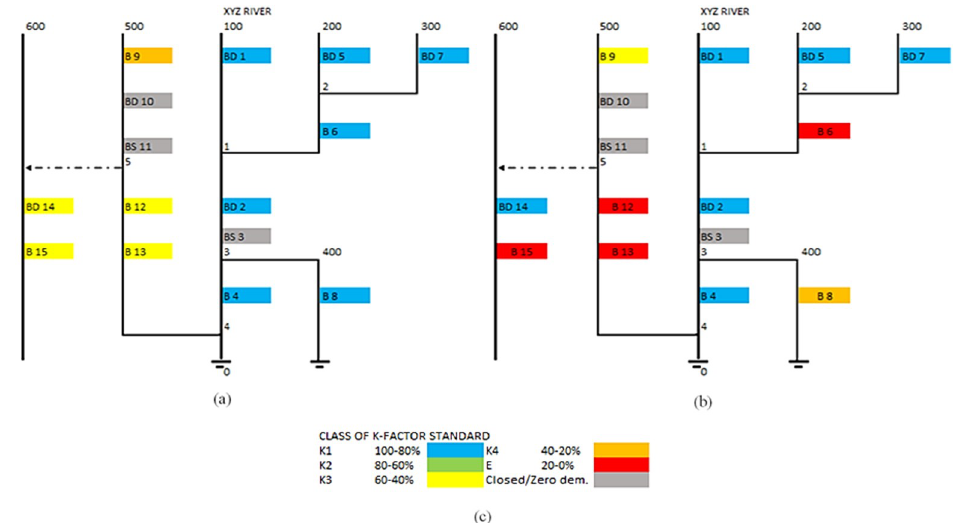
Figure 13. Class of K-factor comparison in the scheme. ( a ) With equalization; ( b ) Without equalization (FCFS method); ( c ) Class of K-factor standard.